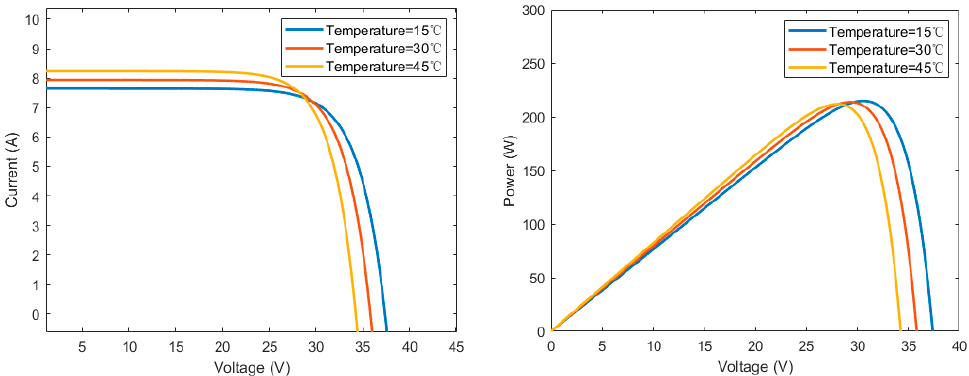
Figure 2. Characteristic curves of constant irradiance and change of temperature.